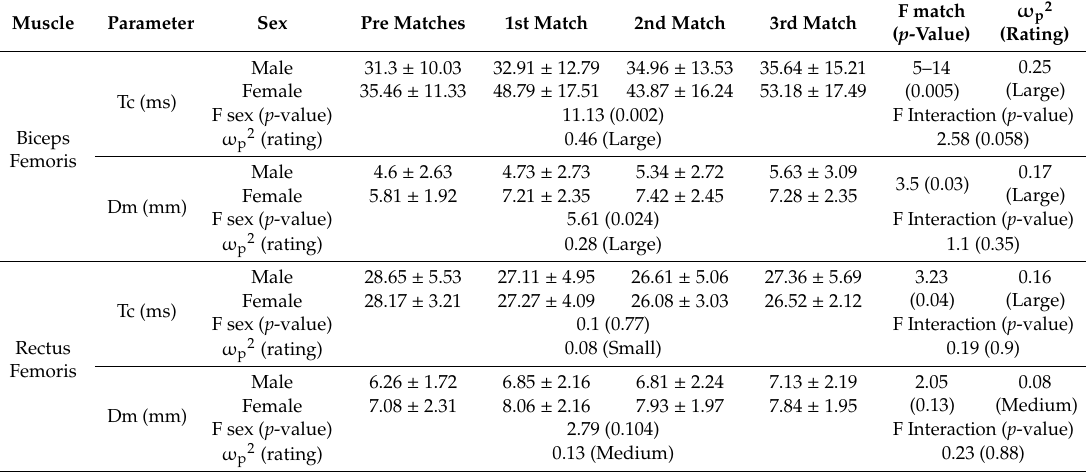
Table 1. Analysis of muscle mechanical function throughout matches by sex.